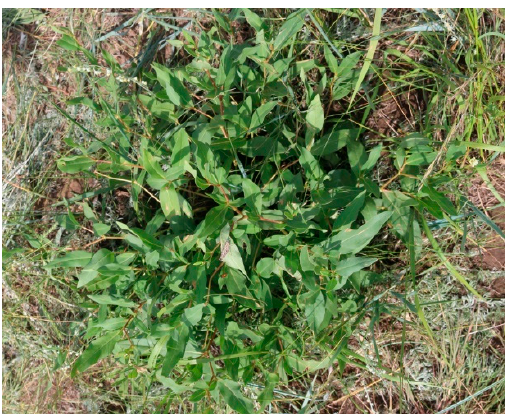
Figure 6. Photo of Polygonum divaricatum from Baiyinkulun Grassland. Haplophyllum dauricum